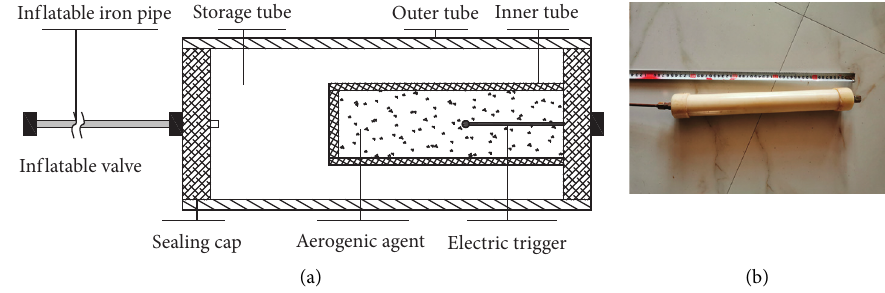
Figure 6: Expansion pipe. (a) Structure schematic drawing. (b) Product picture.